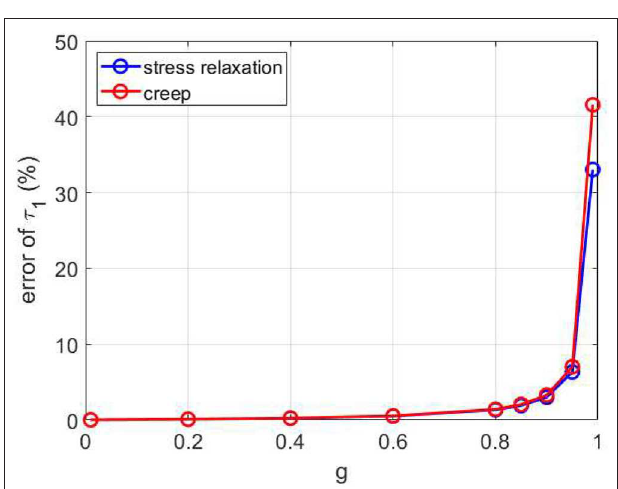
FIGURE 7 | The error of τ 1 increased nonlinearly with increasing g .